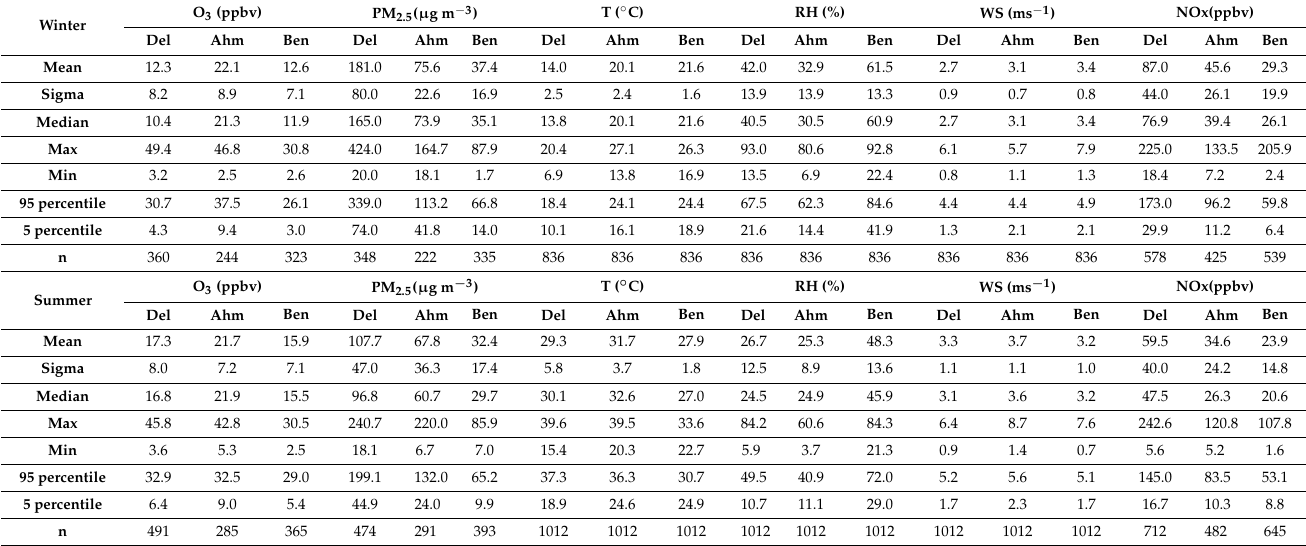
Table 1. Statistics of the winter and summer data from NASA/POWER and